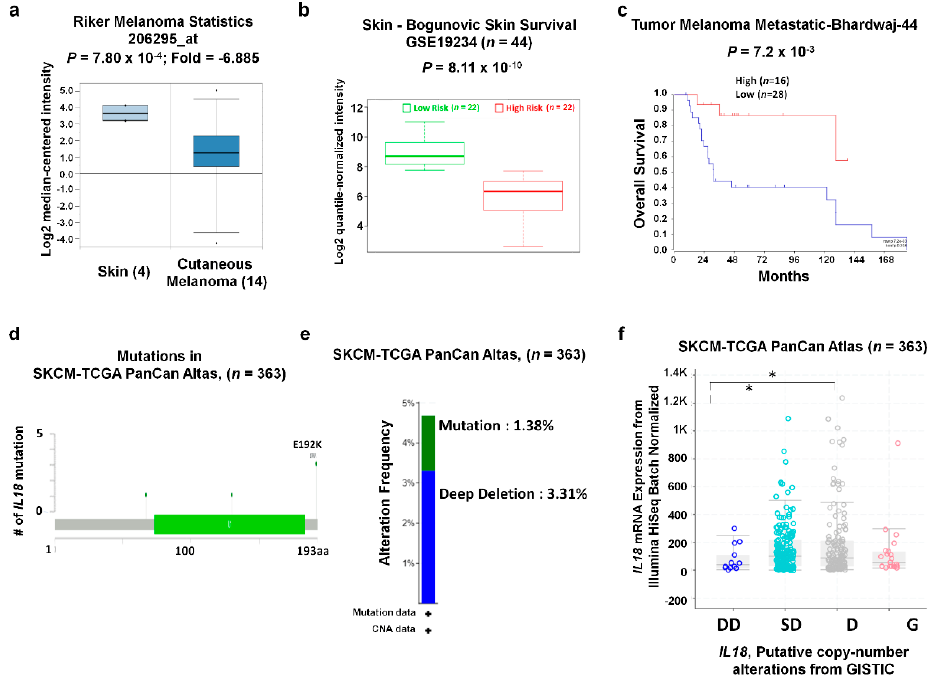
Figure 3. IL18 expression and genome alterations in SKCM. ( a ) A box plot comparing specific IL18 expression in normal ( n = 4, left plot) and cancer tissues ( n = 14, right plot) was derived from the Riker Melanoma dataset in the Oncomine database. ( b ) IL18 expression in high (red) and low (green) risk patient groups in the Gene Expression Omnibus (GEO) dataset GSE19234 were visualized with a box-plot using the SurvExpress biomarker validation tool [36]. Expression of IL18 was represented quantile-normalized and log2 transformed intensity data in GSE19234 dataset in Y -axis. The t -test was